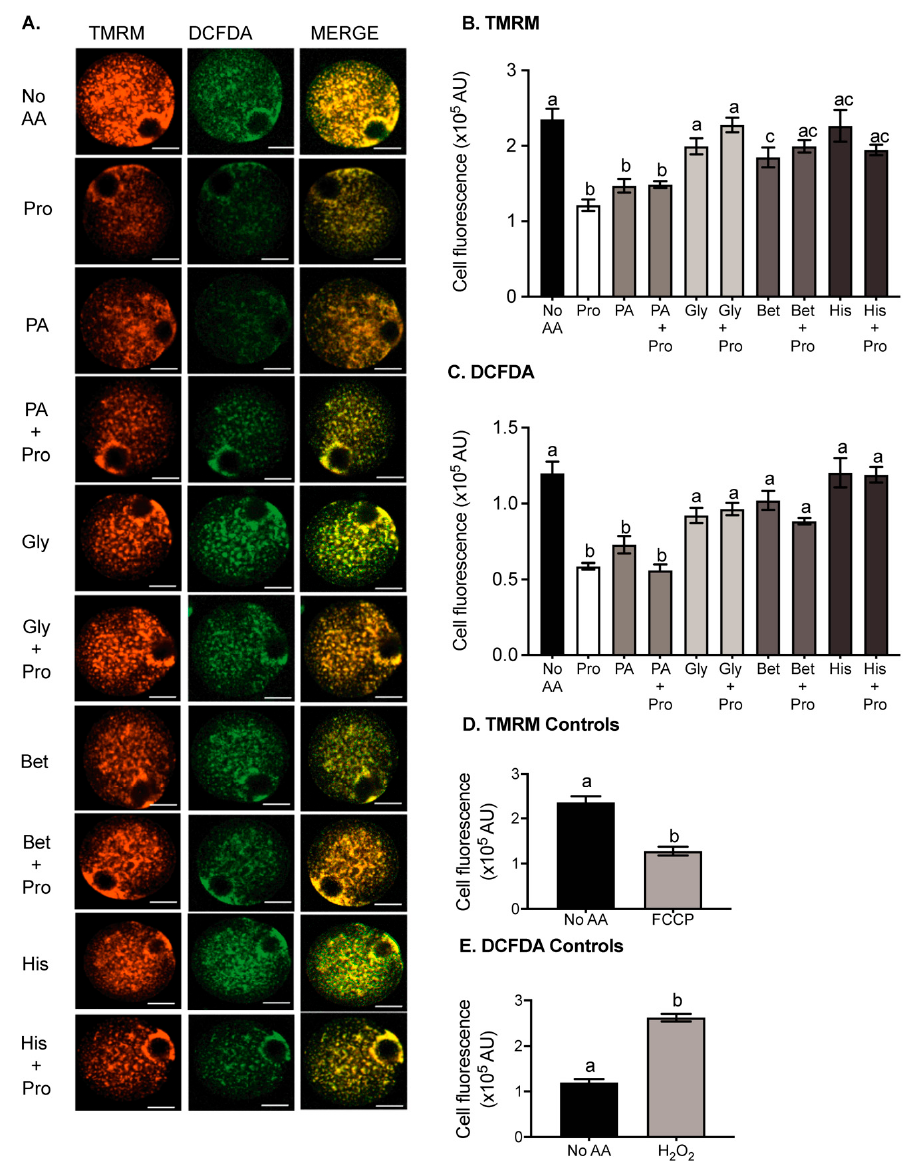
Figure 4. The effect of amino acids on ROS production and mitochondrial activity in oocytes. Oocytes were incubated for 3 h in medium containing either no amino acids (no AA) or 0.4 mM Pro or 0.4 mM PA, Bet, His, or Gly ± 0.4 mM Pro. Oocytes were then loaded with DCFDA for ROS, and TMRM for mitochondrial activity, and imaged by confocal microscopy. ( A ) Representative fluorescent images of oocytes in each condition. Quantified cell fluorescence for ( B ) TMRM and ( C ) DCFDA. Bars represent mean ± SEM for 28–71 oocytes, obtained from at least 3 independent experiments. Control oocytes stained with ( D ) TMRM and ( E ) DCFDA were transferred to a 10 µ L medium containing 60 µ M H 2 O 2 or 5 µ M carbonyl cyanide-p-trifluoromethoxyphenylhydrazone (FCCP) before imaging. Scale bar = 20 µ m for all images. Data were compared by 1-way ANOVA with Tukey’s multiple comparisons test. Bars not sharing the same letter are significantly different ( p <